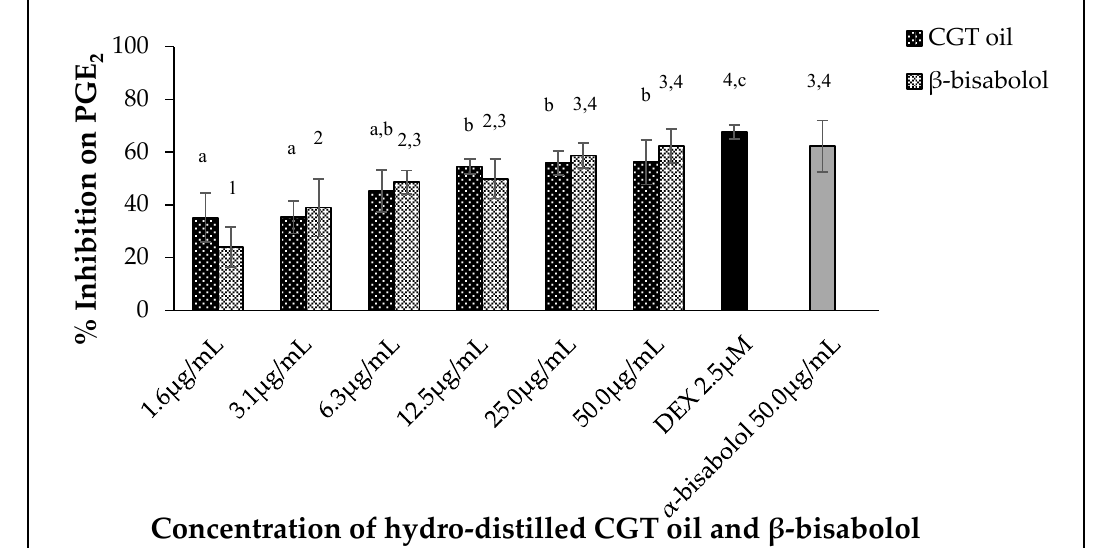
Figure 4. Effect of CGT oil and β -bisabolol dilutions on PGE 2 production in RAW 264.7 cells. RAW 264.7 cells were exposed to test extracts or compounds for 1 h and then induced with 100